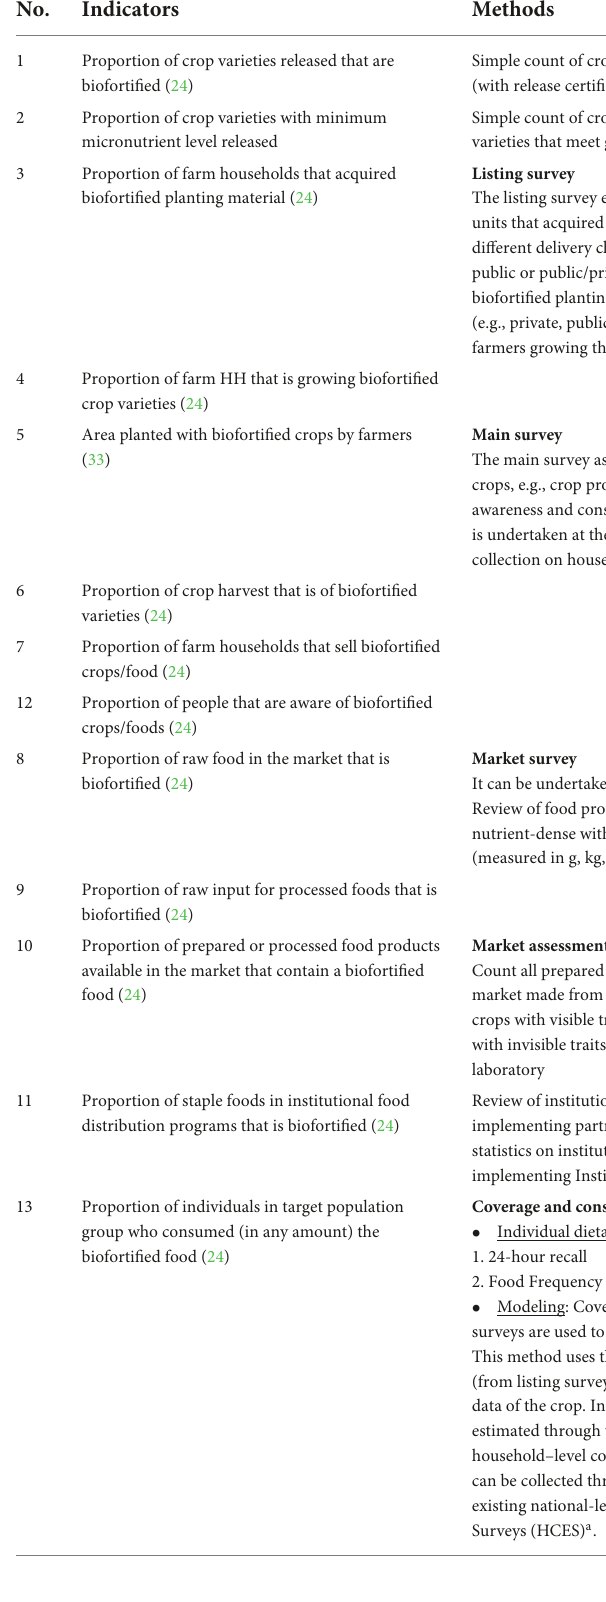
TABLE 7 Summary of methods and tools for constructing the set of high-level